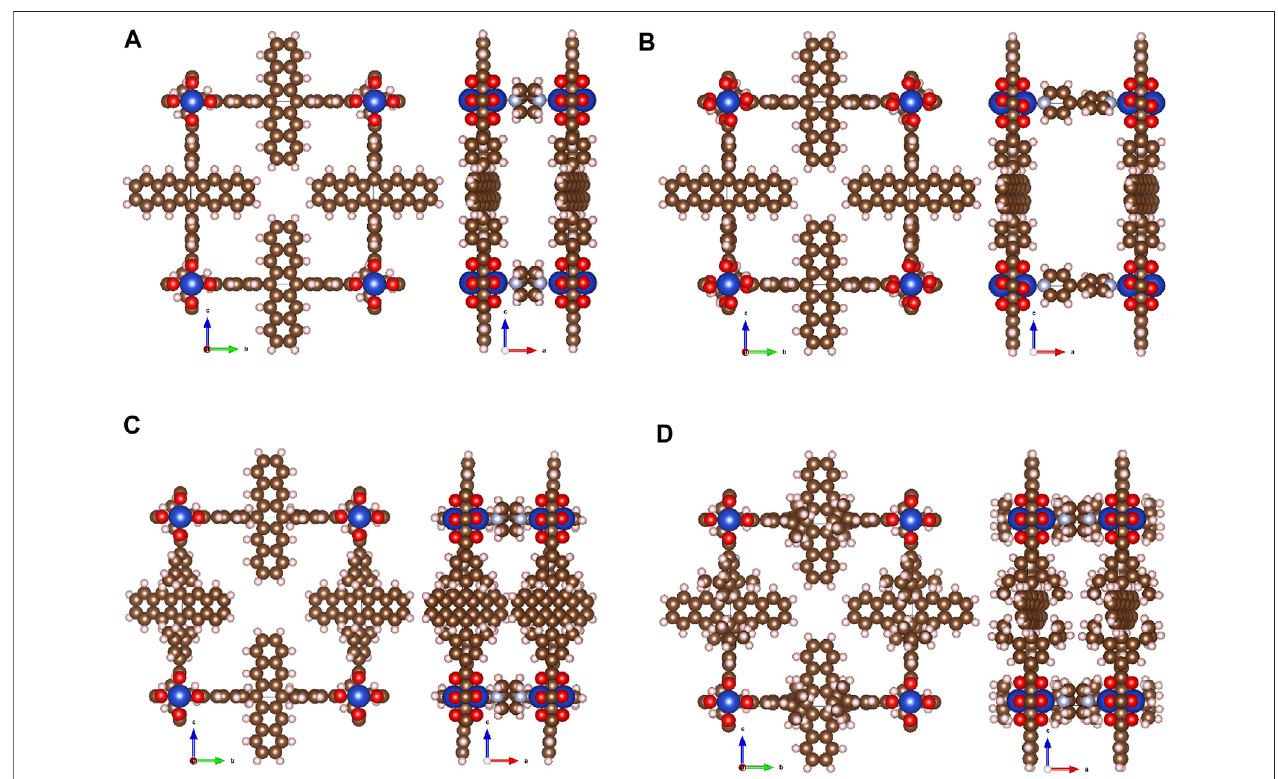
FIGURE 6 | Representative structures of MOF of PCU topology obtained automatically after MOF Builder and MOF Optimizer parts of the work fl ow starting from coordinate fi les of linkers and speci fi cation of SBU type: Cu 2 (Pn) 2 (DABCO) (A) , Cu 2 (Pn) 2 (bipy) (B) , Cu 2 (Me-Pn) 2 (DABCO) (C) , Cu 2 (iPr-Pn) 2 (DABCO) (D) .